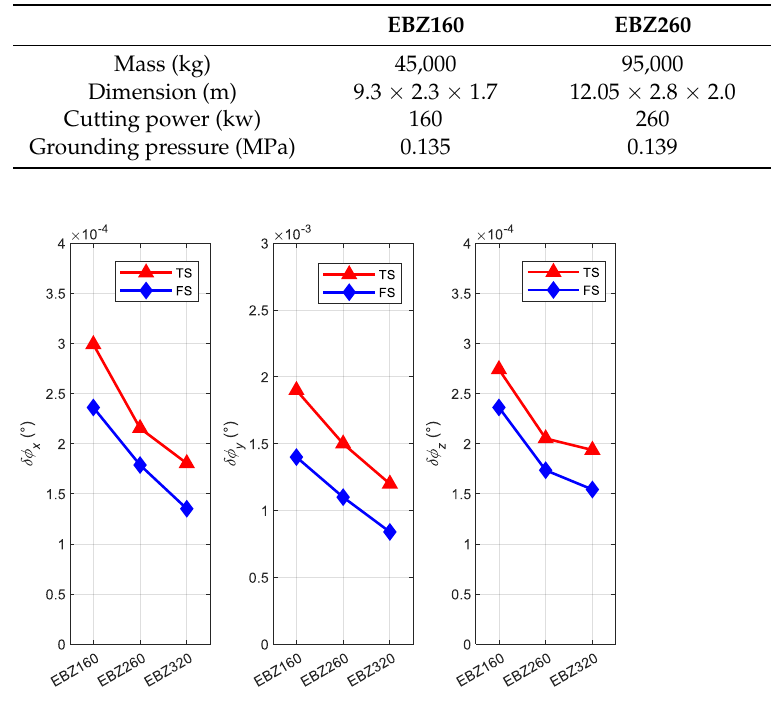
Table 4. The technical parameter table of roadheader.